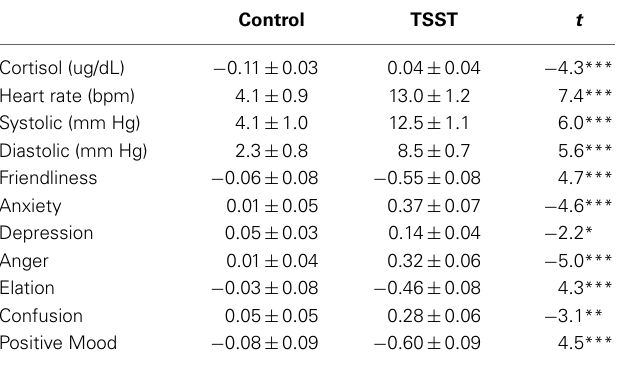
Values indicate mean ± s.e.m. Asterisks indicate a significant difference